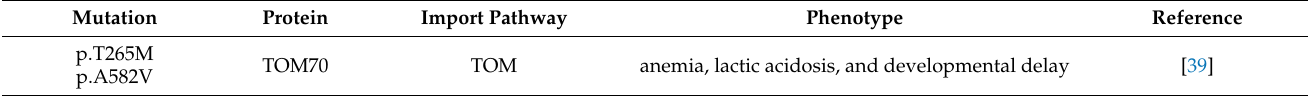
Table 1. Mutations identified in different genes involved in protein traslocation and associated with disease.